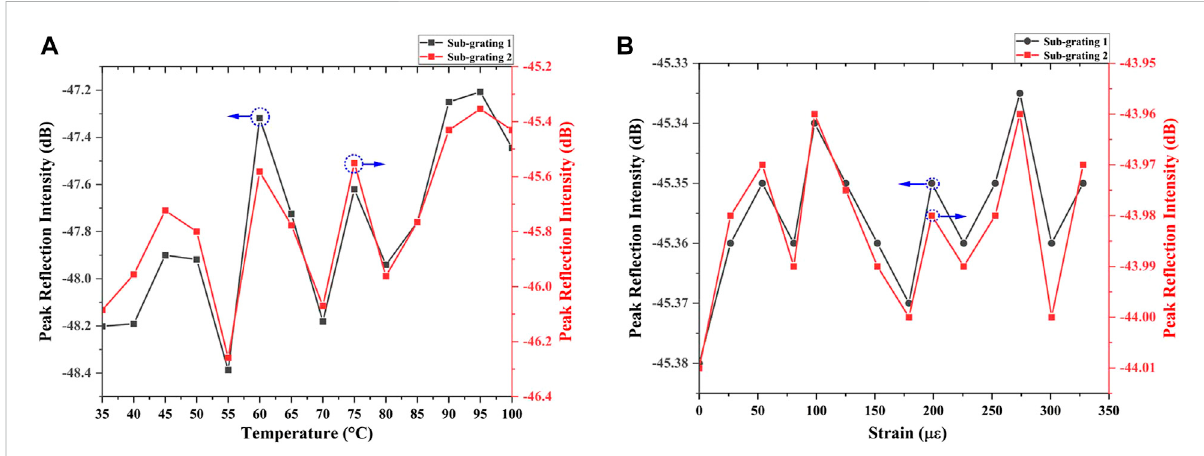
FIGURE 7 Synchronization test results of two sub-gratings. (A) The peak re fl ection intensity of 2D FBG in temperature sensing experiments. (B) The peak re fl ection intensity of 2D FBG in strain sensing